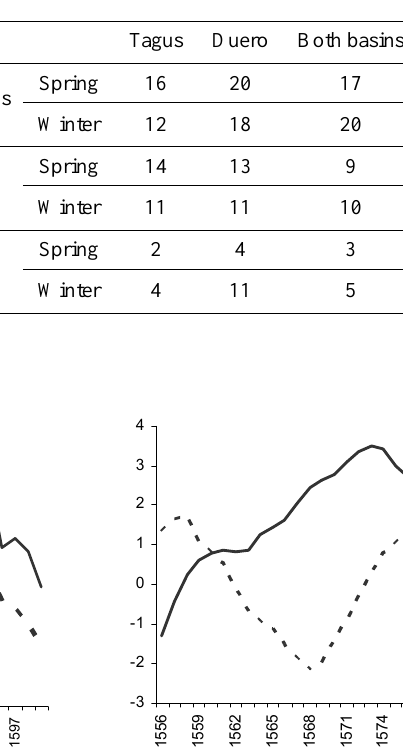
Table 3. Relationships between precipitation and floods in the Tagus and Duero basins.